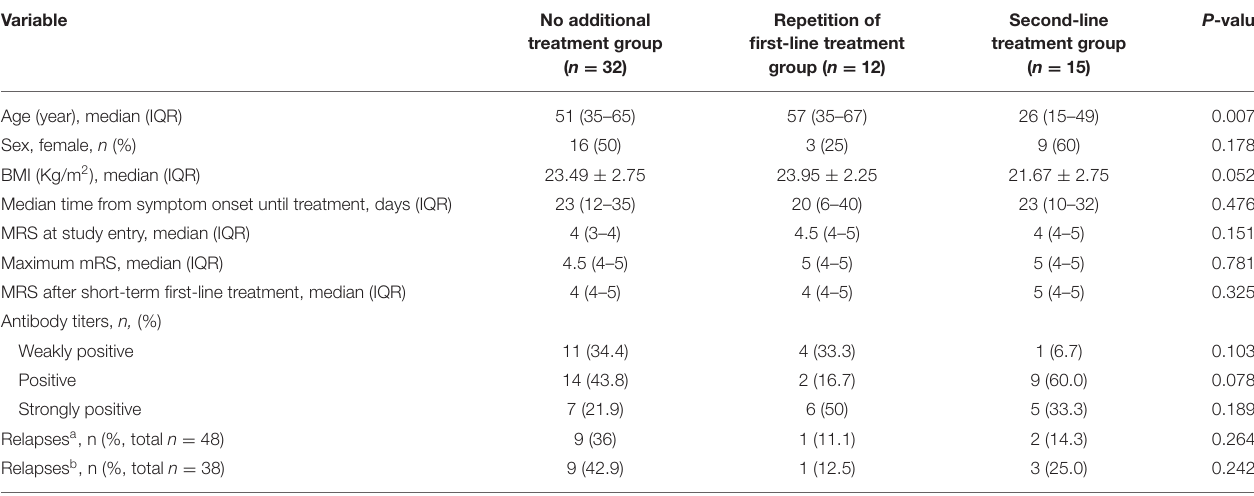
TABLE 6 | Characteristics and outcomes of patients with AE who failed short-term first-line immunotherapy. Variable